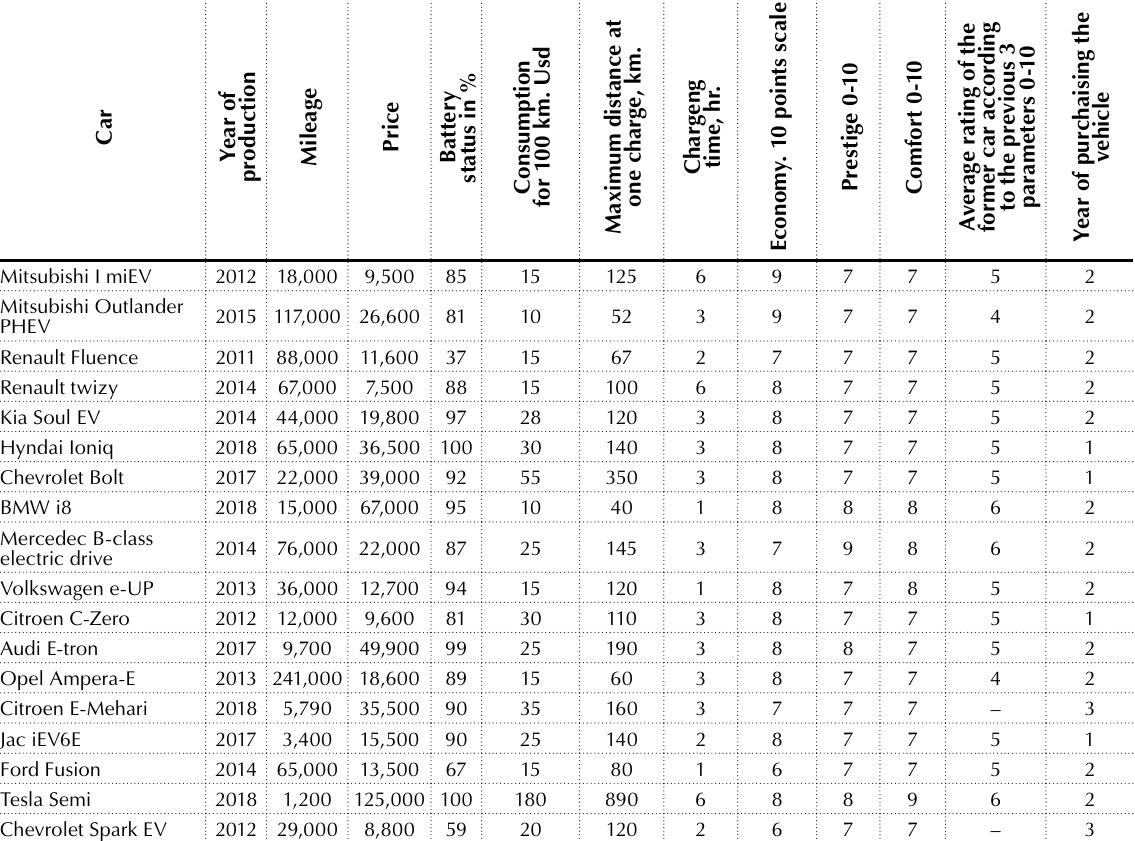
Table 2. Correlation matrix of the given factors